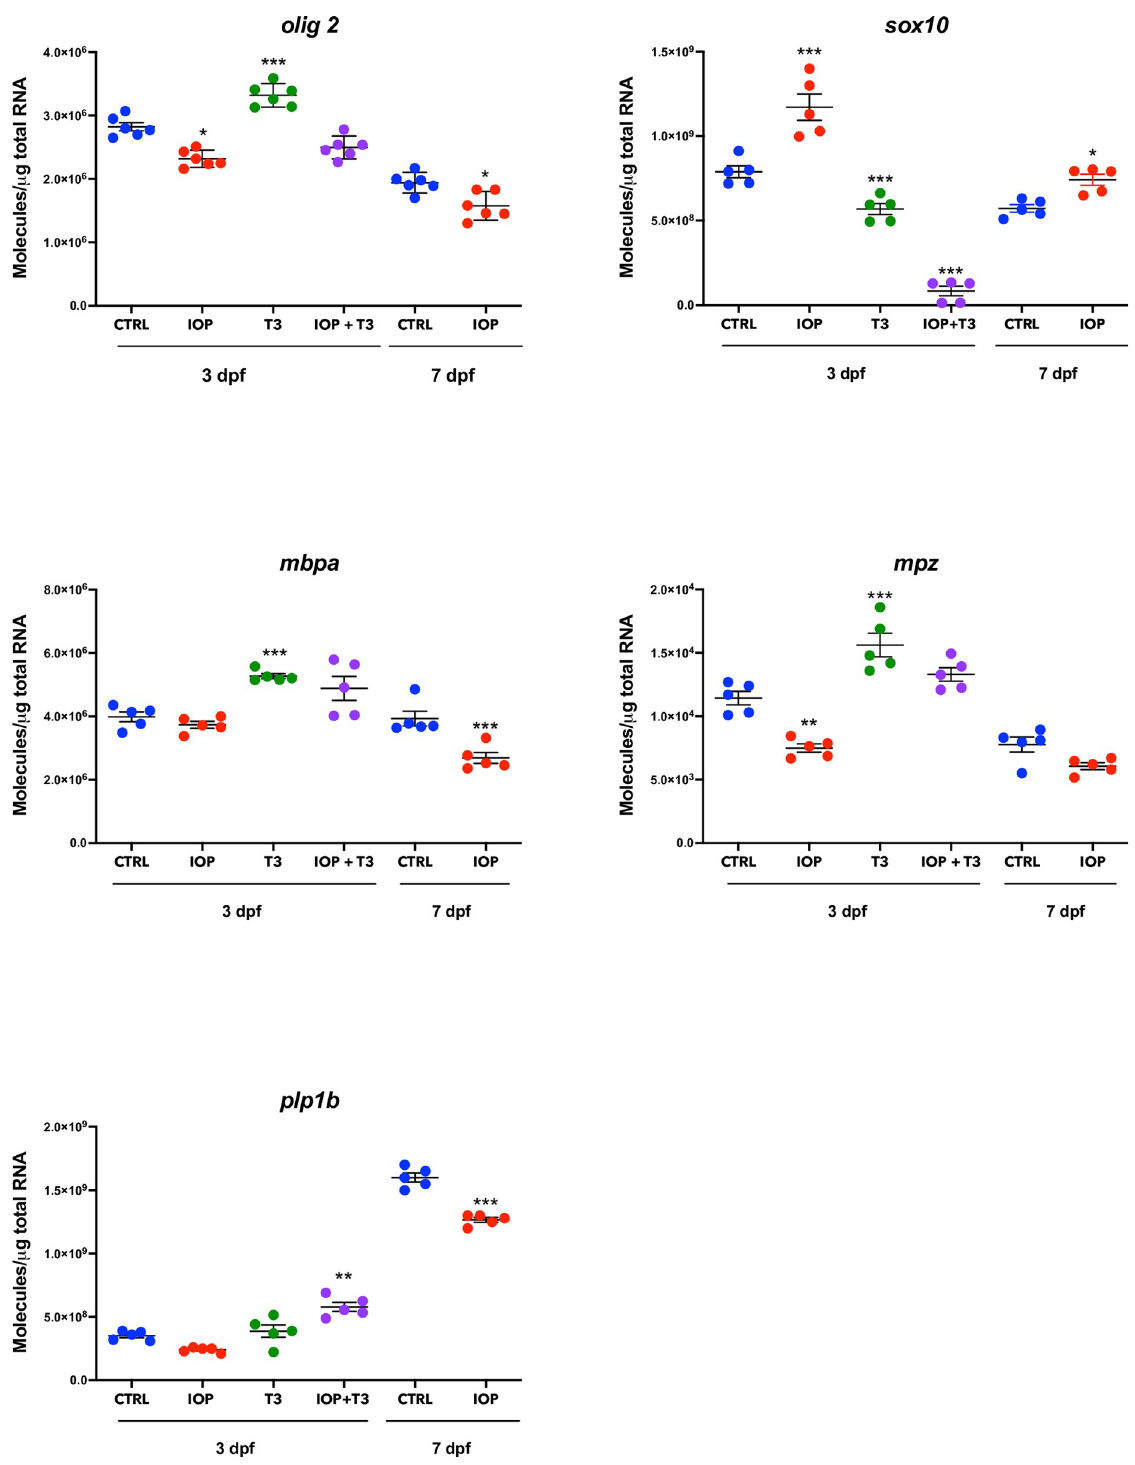
Fig 4. Changes in expression of myelin-related genes in zebrafish larvae exposed to IOP. mRNA quantification of olig2 , sox10 , mbpa , mpz and plp1b in controls and larvae exposed to IOP 0.5 μ M, T3 10 nM or IOP 0.5 μ M + T3 10 nM for 3 dpf and to IOP 0.5 μ M for 7 dpf. Data are represented as individual values in vertical graphs (n = 5 pools from independent experiments of 50–60 larvae per pool and condition). Graphs are showing individual values and mean ± SEM. Statistical analysis was performed with one-way ANOVA coupled with Tukey’s multiple comparison test with respect to the corresponding control groups. Significant differences are indicated as � p < 0.05, �� p < 0.01, and ��� p < 0.001. https://doi.org/10.1371/journal.pone.0256207.g004 PLOS ONE | https://doi.org/10.1371/journal.pone.0256207 August 17,